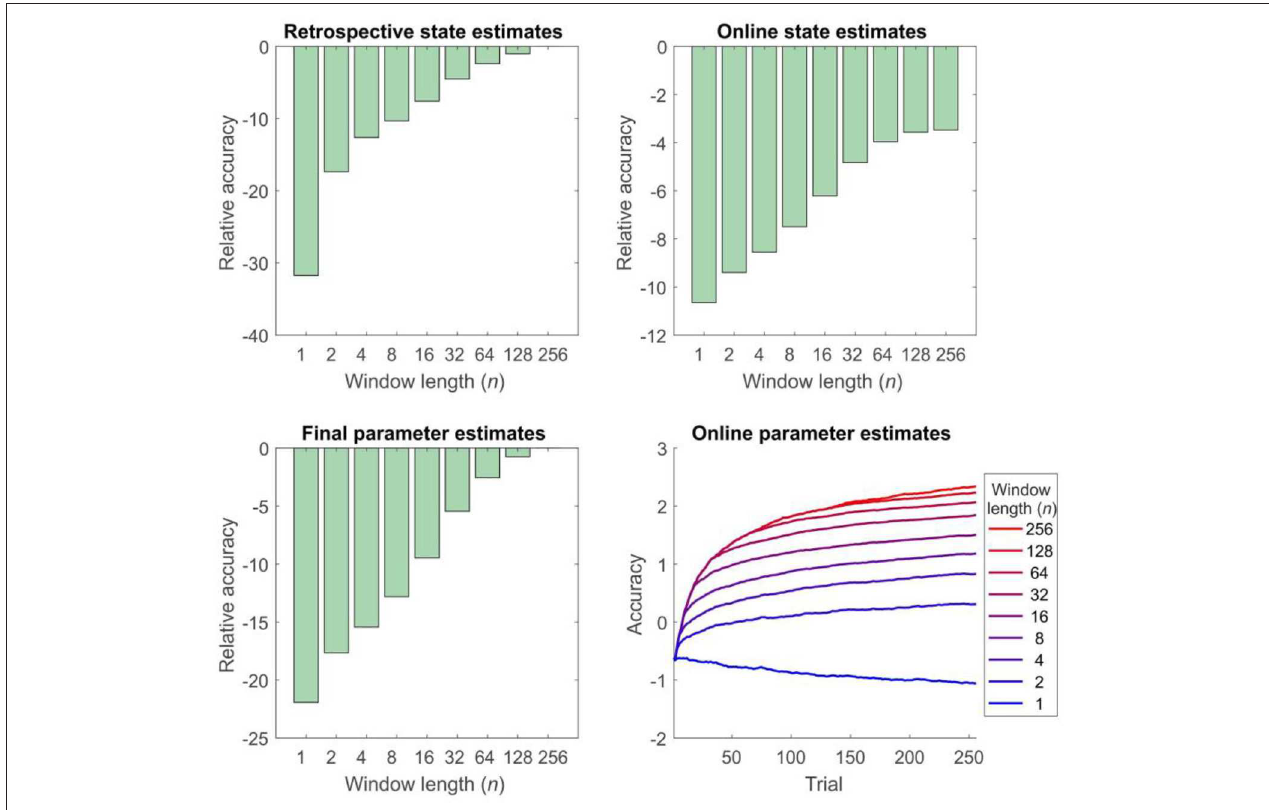
FIGURE 5 | Accuracy of inference and learning on the reversal task for agents using different window lengths, averaged across 1,000 simulations (see “Simulations” for more details). Accuracy is quantified as the log likelihood assigned to the true sequence of states or the true parameter value by the agent, averaged across simulations. Top left panel: accuracy of retrospective state estimation relative to the performance of an offline agent. Accuracy increases with window length, becoming identical for online and offline agents with the same effective window length (256 trials). Top right panel: accuracy of online (filtered) state estimates relative to the filtered state estimates of an offline agent. Accuracy increases with window length, but never becomes equivalent to that of an offline agent. This difference reflects the fact that the parameter estimates of the online agent only use observations made up to the present time, rather than on the entire data set (In other words, p (θ | o 1 : t , λ) at trial t rather than p (θ | o 1 : T , λ) ). This can be thought of as a cost of online inference. Bottom left panel: accuracy of final parameter estimates relative to the performance of an offline agent. Accuracy progressively increases with window length, becoming equivalent for online and offline agents with the same effective window length. Bottom right panel: average accuracy of parameter estimates across trials. Accuracy of parameter estimation increases with window length, and these differences progressively appear as the session goes on. (Absolute values of the accuracy measure are difficult to interpret here, but the relative accuracy of the difference agents is